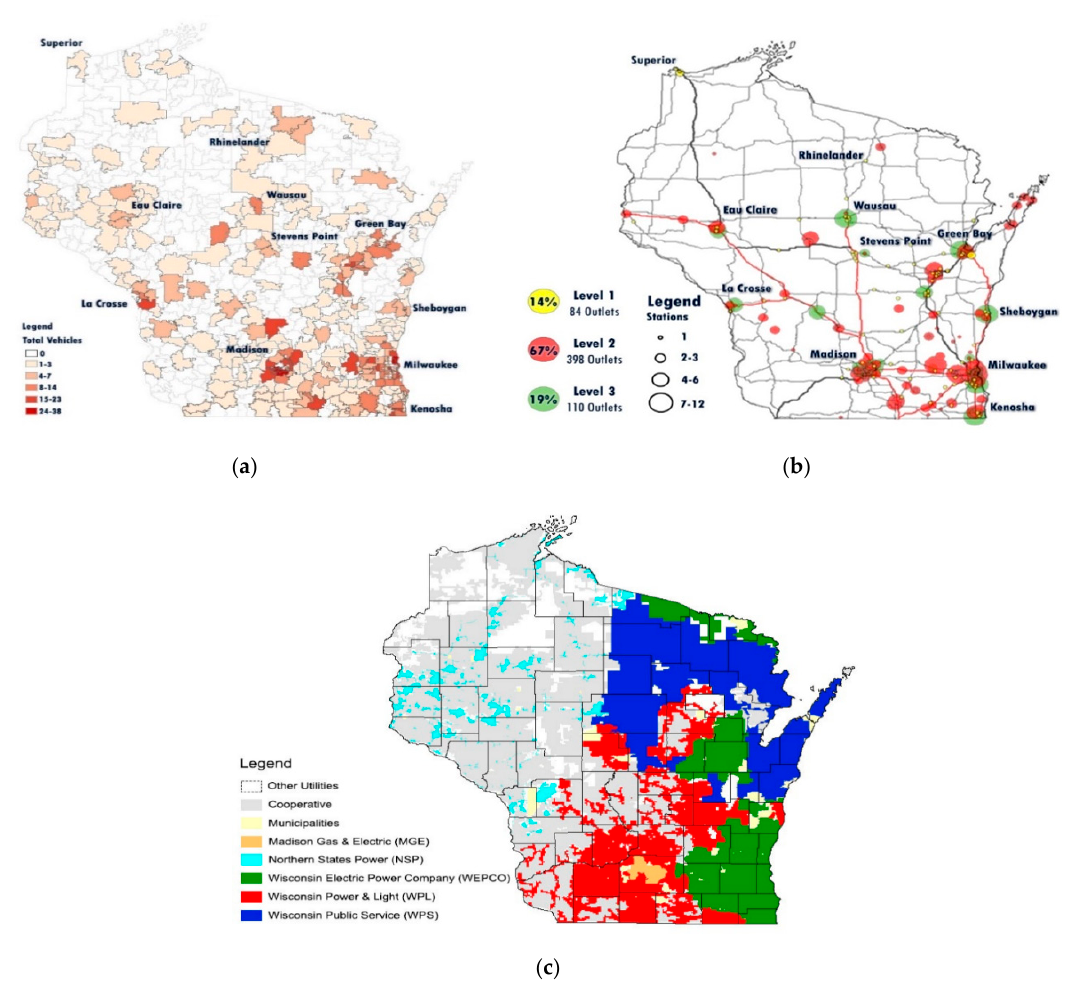
Figure 1. ( a ) Electric vehicle (EV) registrations in the State of Wisconsin as of September 2018 by zip code, data from [12]. ( b ) Plug-in Electric Vehicle (PEV) charger locations in Wisconsin by charging level, data from [13]. ( c ) Major Wisconsin utility jurisdictions and corresponding county, data from